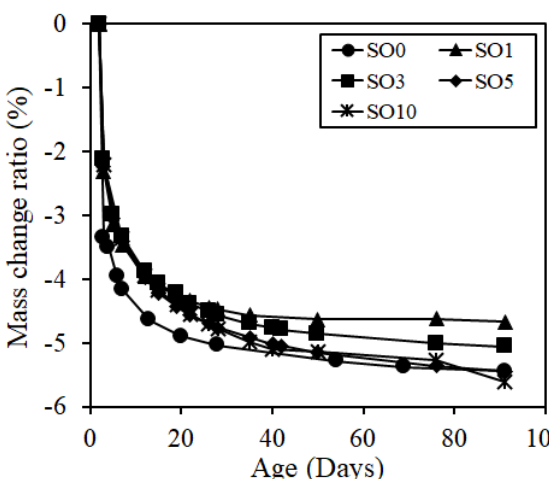
Figure 6. Cure shrinkage.